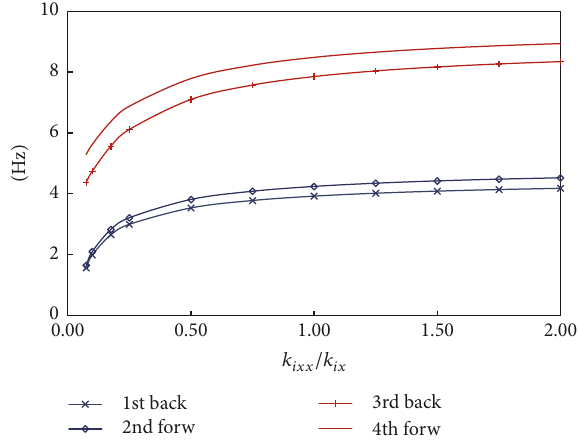
Figure 14: Natural frequencies of LHG rotor in function of the rate between bearing stiffness and bracket